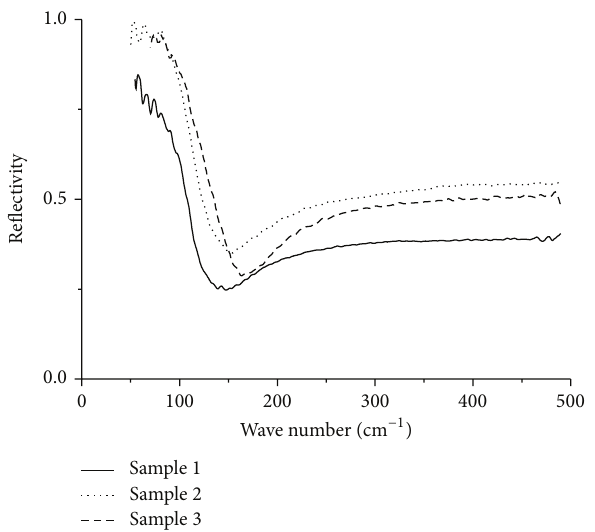
Figure 3: Room temperature FIR diagrams of PbTe doped with 0.29 at% Cu (Sample 1, “beginning”), 0.24 at% Cu (Sample 2, “middle”), and 0.23 at% Cu (Sample 3, “end”)—first ingot.